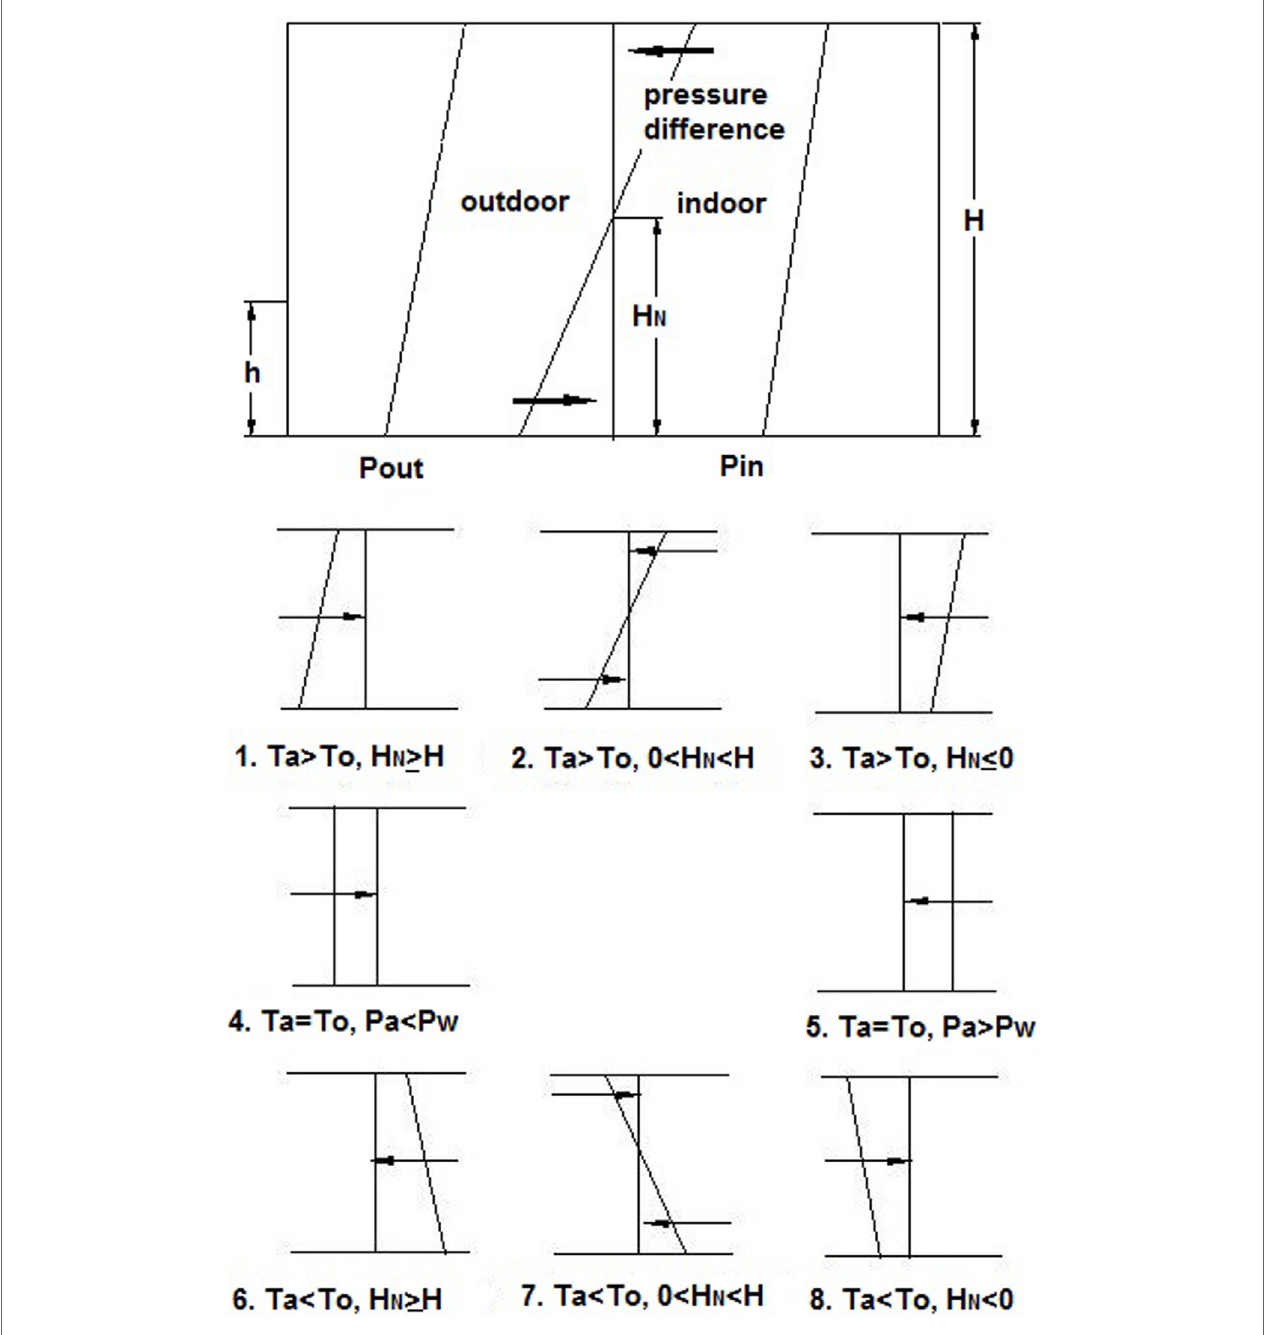
FigUre 1 | air flow through the window due to stack effect and wind pressure